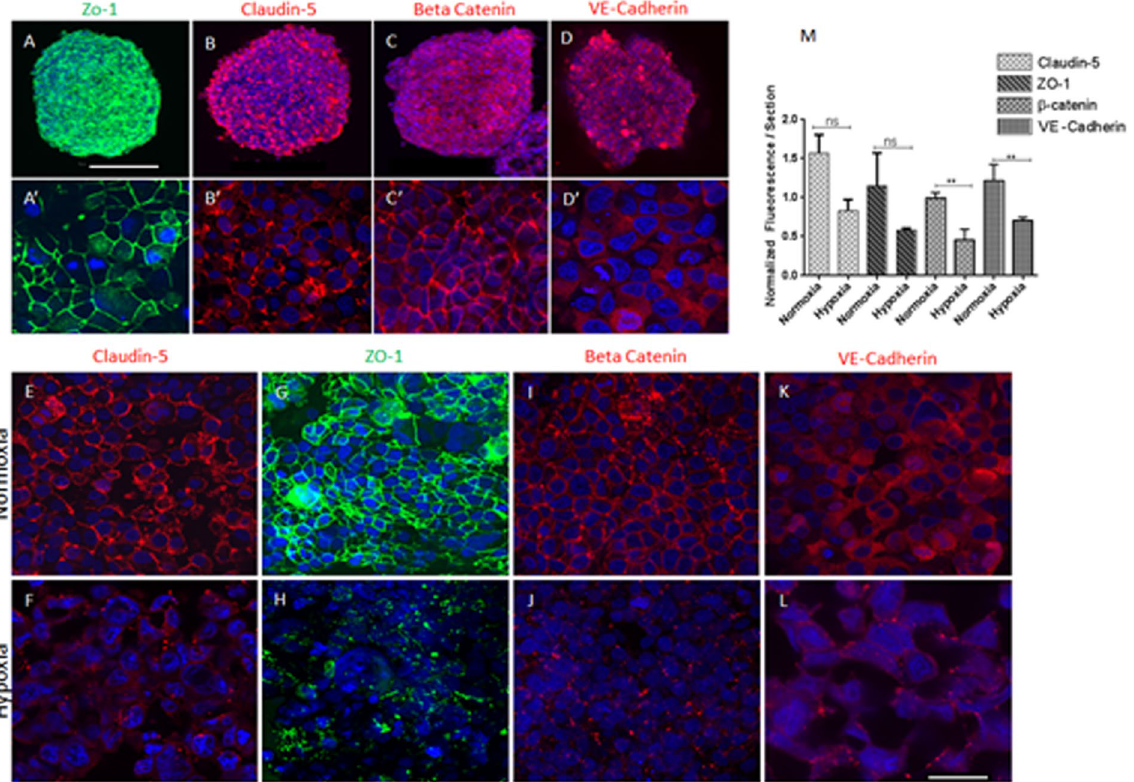
Figure 3. Blood-brain barrier marker expression and effect of hypoxia on tight and adherens junction protein distribution. The presence of tight junction markers Zona occludens-1 (ZO-1) ( A ), claudin-5 ( B ), and adherens junction proteins β -catenin ( C ) and VE-Cadherin ( D ) were confirmed via immunofluorescent staining and confocal microscopy at 10x. The lower panels in A ′ –D ′ are parts of spheroids in A–D taken at higher panels in ( F , H , J , & L ) show spheroids that were cultured under hypoxic conditions at 37 °C, 0.1% O 2 for 24 hrs prior to immunofluorescent staining and imaging. Spheroids under hypoxic condition exhibited